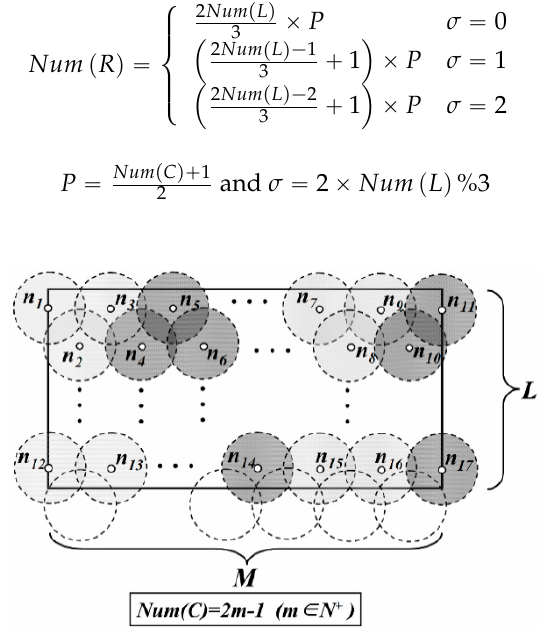
Figure 5. Distribution of DGAs ( Case 4 ).